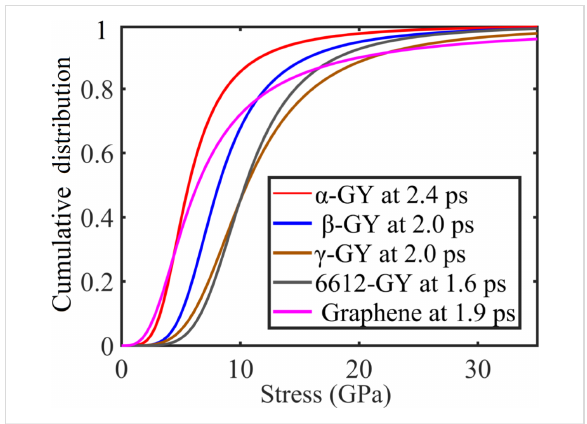
Figure 5: Cumulative distribution function (CDF) of the von Mises atomic stress distribution before crack initiation for different nano- sheets under an impact velocity of 2 km/s.